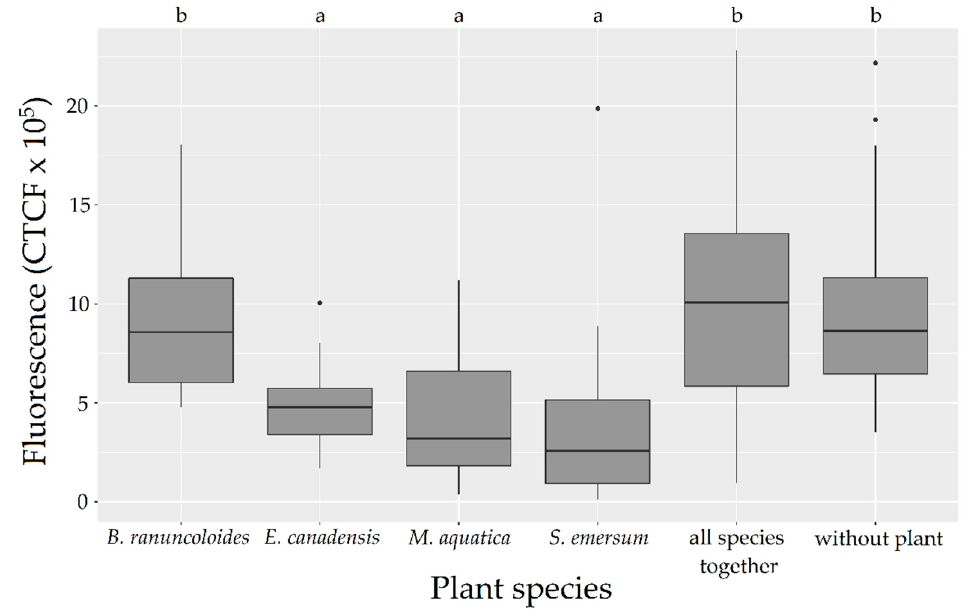
Figure 2. Effects of Baldellia ranunculoides ( n = 3), Elodea canadensis ( n = 3), Mentha aquatica ( n = 3), Sparganium emersum ( n = 3), the mixture of these four species together ( n = 3) and the absence of plants ( n = 3) on the fluorescence of GFP- E. coli in the rhizotrons. Boxplots of fluorescences measured on days 1, 2, 3, 6 and 8 (fluorescences > LOD) in the water of rhizotrons inoculated with GFP- E. coli . Using an ANOVA with a multiple comparisons Tukey’s test on the l-mm, testing the effects of plant species on the fluorescence (i.e., bacterial concentration) of the water column. a and b are significantly different ( p -value (ANOVA) < 0.001). The dots are outliers.